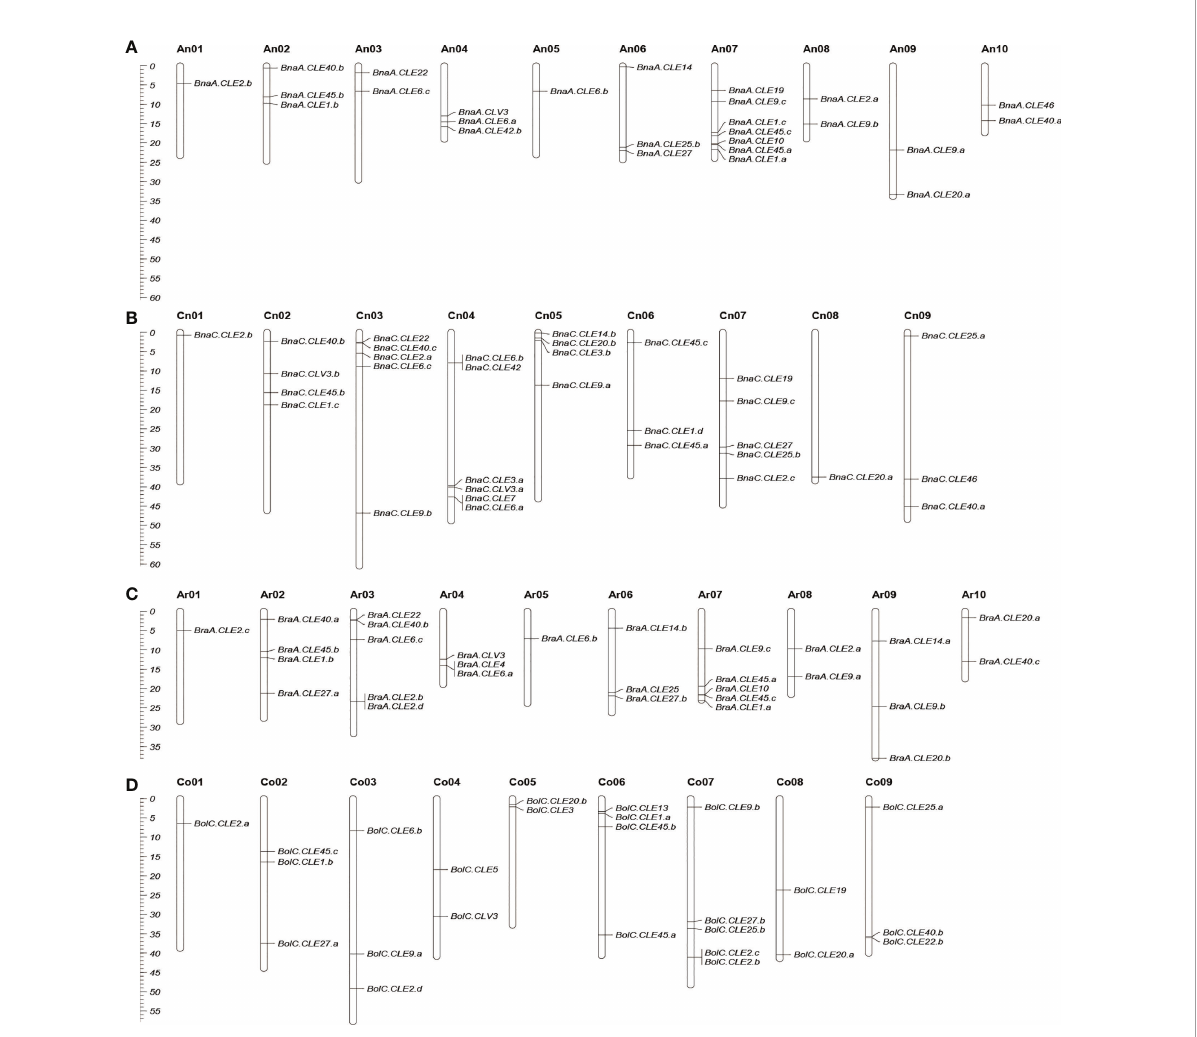
FIGURE 2 Chromosomal location of CLE s in Brassica napus (A, B) , Brassica rapa (C) , and Brassica oleracea (D) . Partial CLE s in B. oleracea and B. napus located in unassembled scaffolds were not shown. The scale on the left is in megabases